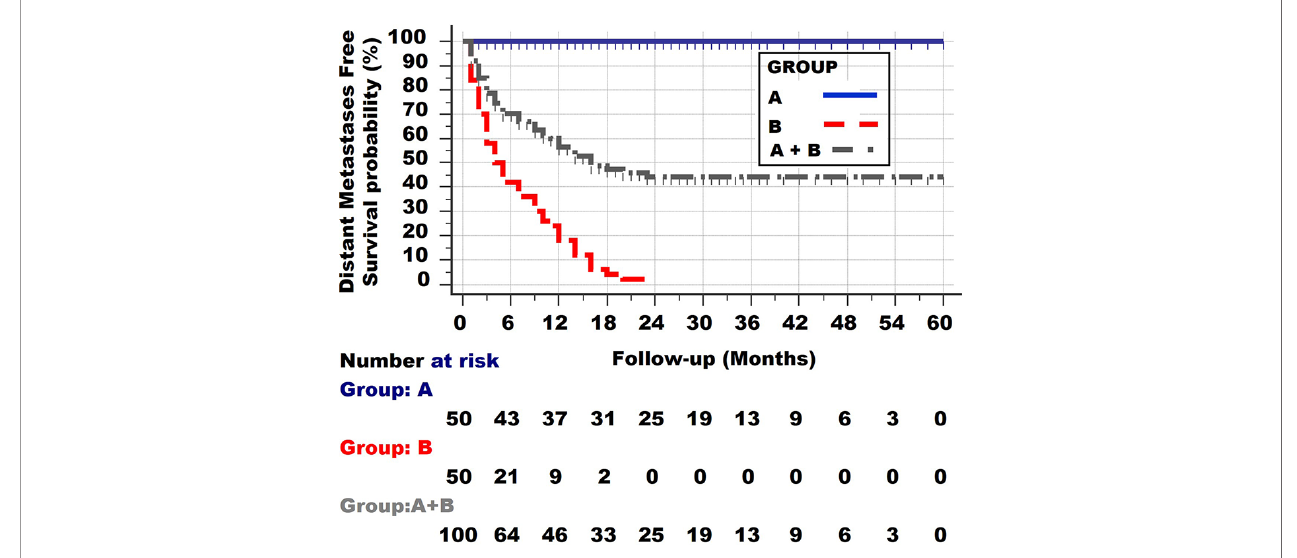
FIGURE 3 | Survival curve of the two patient groups A and B together. Note the initial rather steep decline, followed by an increasingly more horizontal